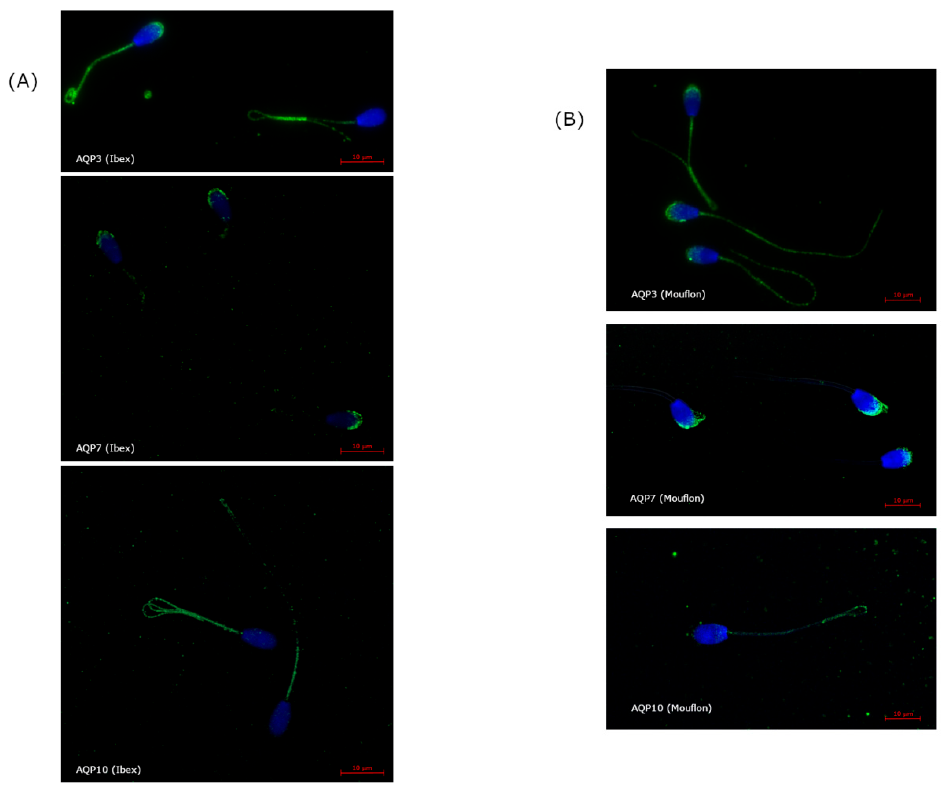
Figure 3. Immunolabeling of AQP3 (located in the acrosome, post-acrosomal region, midpiece, principal piece, and end piece), AQP7 (located in the acrosome), and AQP10 (located in the principal piece and the endpiece) in ibex sperm ( A ), and in mouflon sperm ( B ). For the post-acrosome region, the percentage of sperm showing AQP3 expression decreased ( p < 0.05), but it increased in the midpiece for the MEL and MEL+T4 groups (Figure 4). The greatest ( p < 0.01) expression of AQP7 in the acrosome was seen in the ibexes that received melatonin implants (Figure 5). The percentage of sperm showing AQP10 expression in the mid piece was greater ( p < 0.01) in the MEL than in the control group (Figure 6), while the percentage of sperm with AQP10 expression in the principal piece and end piece was greater ( p < 0.05) in the MEL+T4 group than in the control group (Figure 6). AQP9 was not detected in any group (or species) either by WB or ICC in our defined experimental conditions.